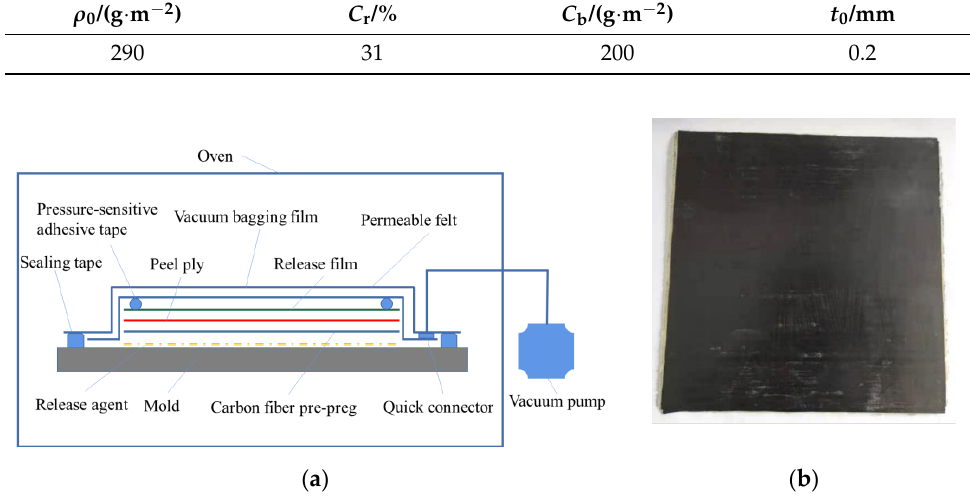
Figure 1. Fabrication of the CFRP laminate: ( a ) Schematic of vacuum-assisted resin infusion process; ( b ) CFRP laminate. ( b ) CFRP